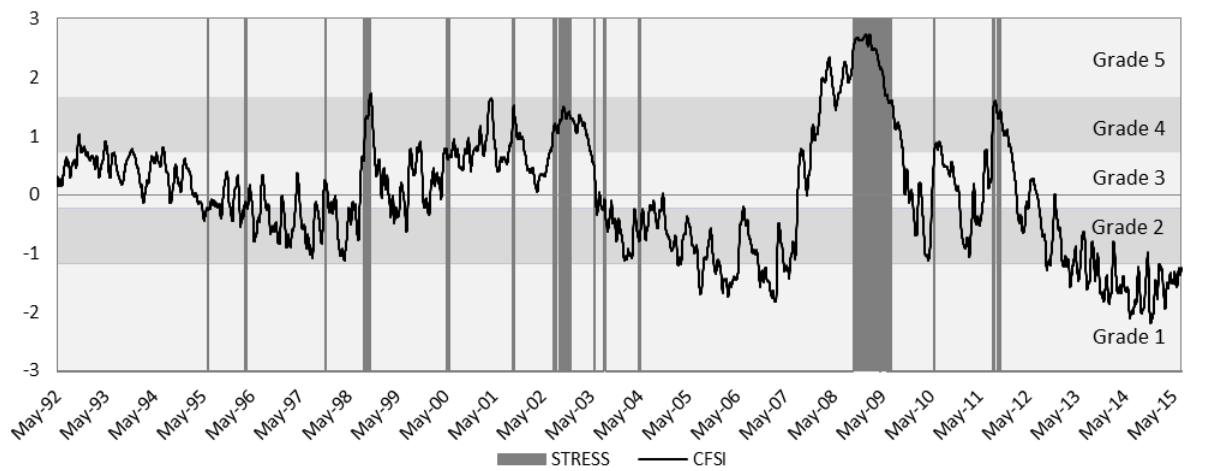
Figure 4. CFSI, grades, and benchmark index of systemic stress